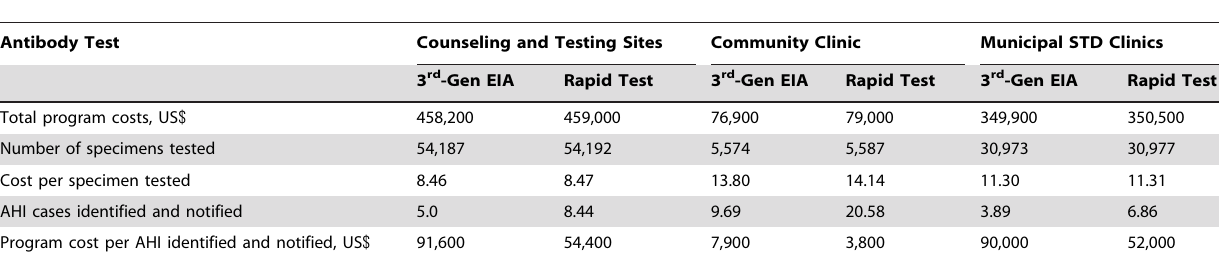
Table 3. Program costs and outcomes of pooled NAAT screening for AHI after third-generation EIA or rapid testing.